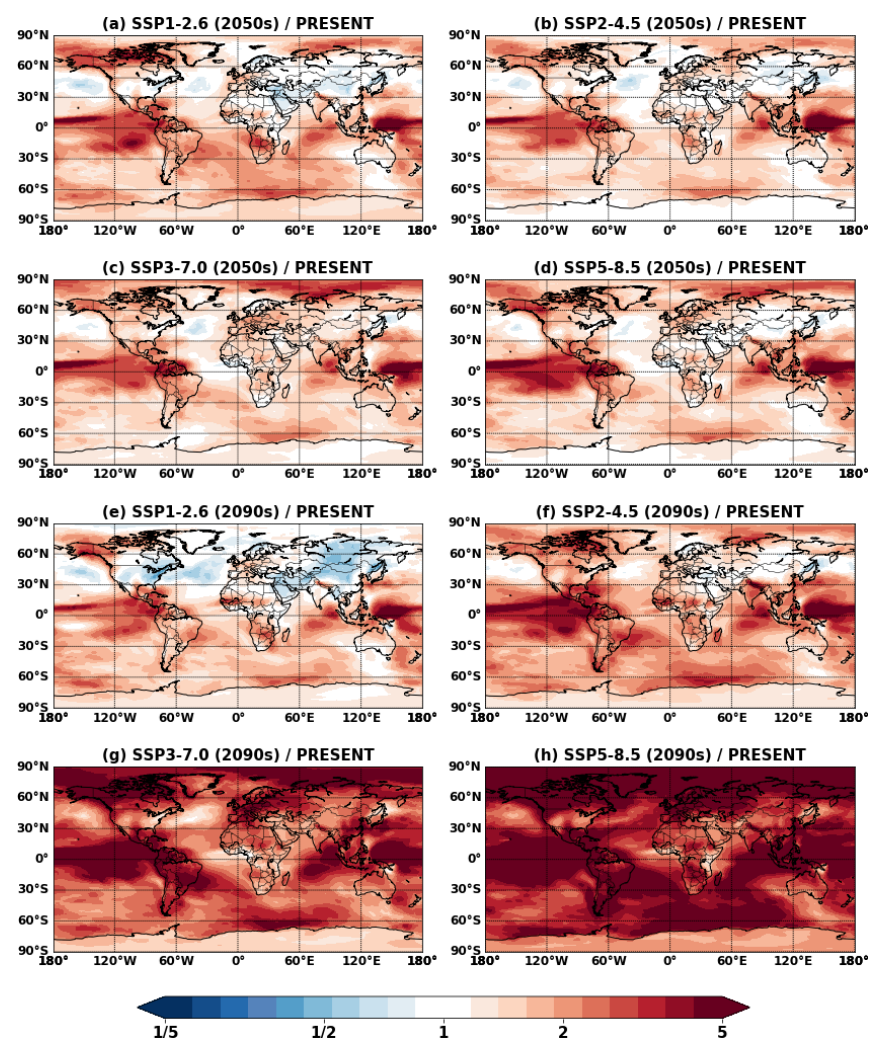
Figure 5. Projected changes in global mean surface IEPOX SOA concentrations from present (EXP_2010) conditions to (a–d) 2050s (EXP_2050_SSPx) and (e–h) 2090s (EXP_2090_SSPx)